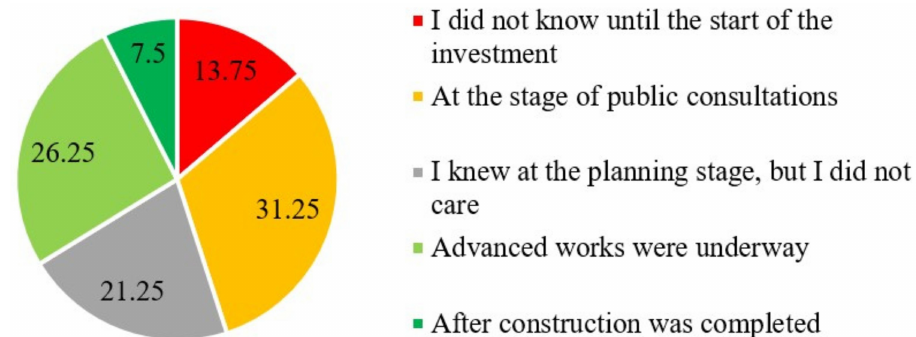
Figure 6. Time when learning about the siting of a wind farm in one’s municipality (%). Source: based on own